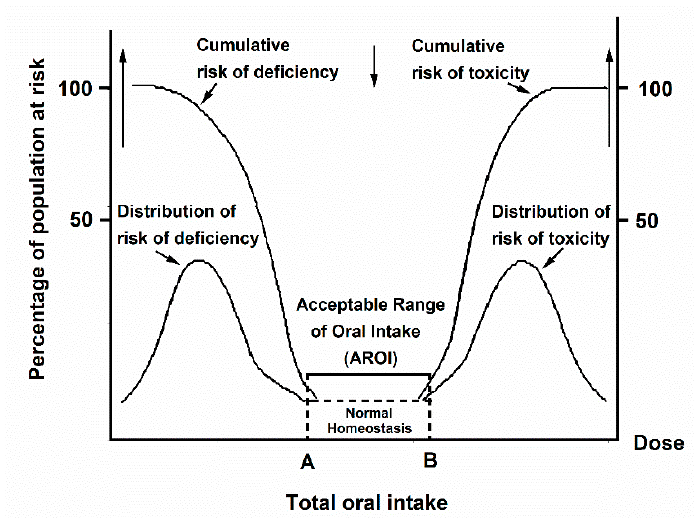
Figure 5. An illustration representing oral intake resulting in deficiency and overload of essential trace elements such as Fe, Cu, and Zn. The area between points A and B on the x -axis referred to as normal homeostasis, describes the ideal range of Cu for a normal and healthy organism. Reproduced with permission from Chambers et al. [94].